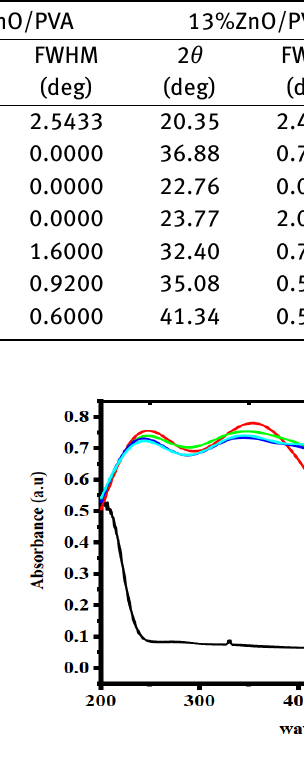
Figure 8: UV-Vis spectra of PVA and ZnO/PVA